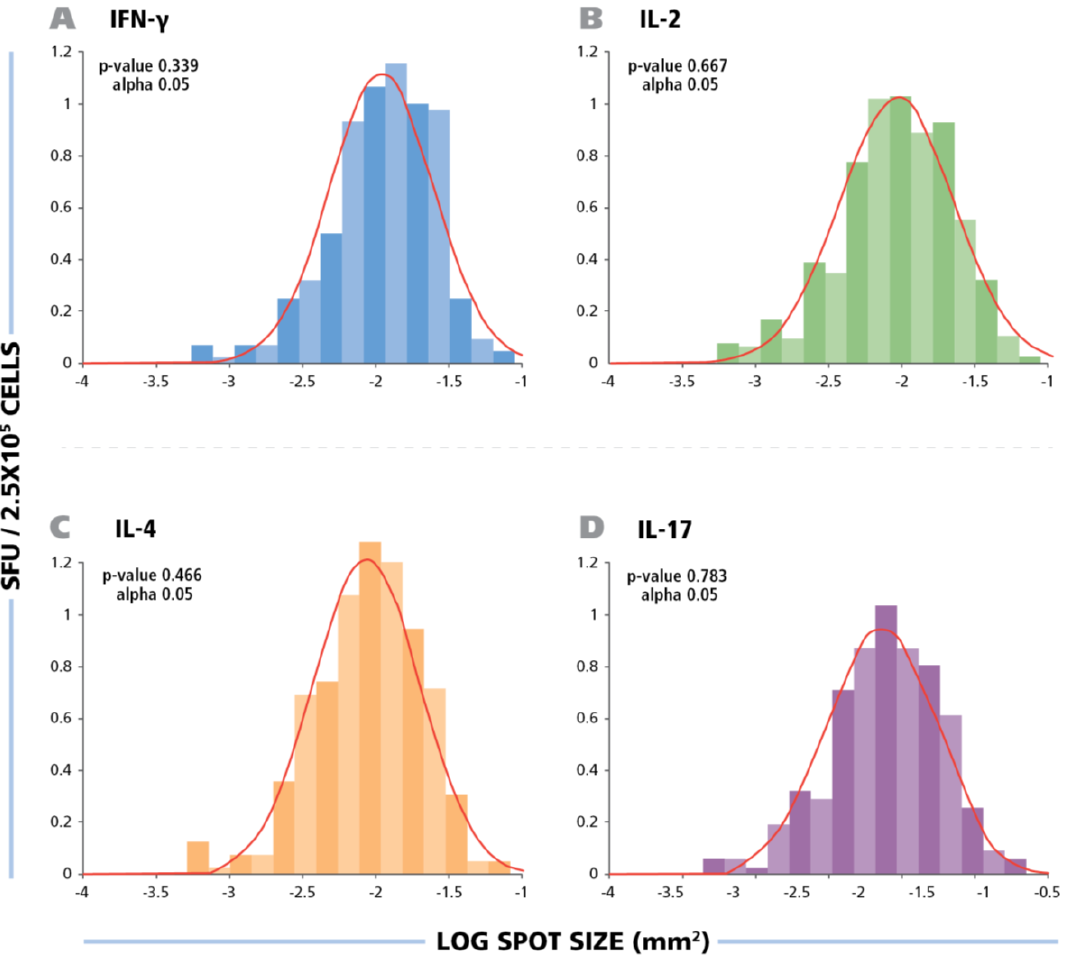
Figure 2. The spot size distribution for different cytokines follow Log Normal distribution. The experimental size distribution of typical recall responses are shown as histograms for the specific cytokines (IFN-g, IL-2, IL-4, and IL-17) with the theoretical Log Normal distribution curve overlaid in red. To test for normality, Kolmogorov-Smirnov goodness of fit was used.